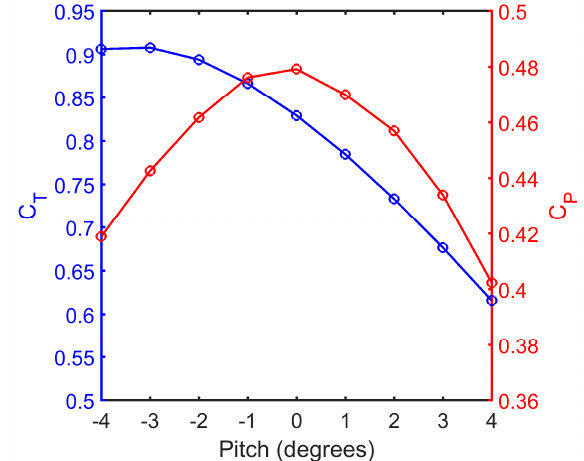
Figure 4. Variation of turbine thrust and power coefficients with blade pitch angle.